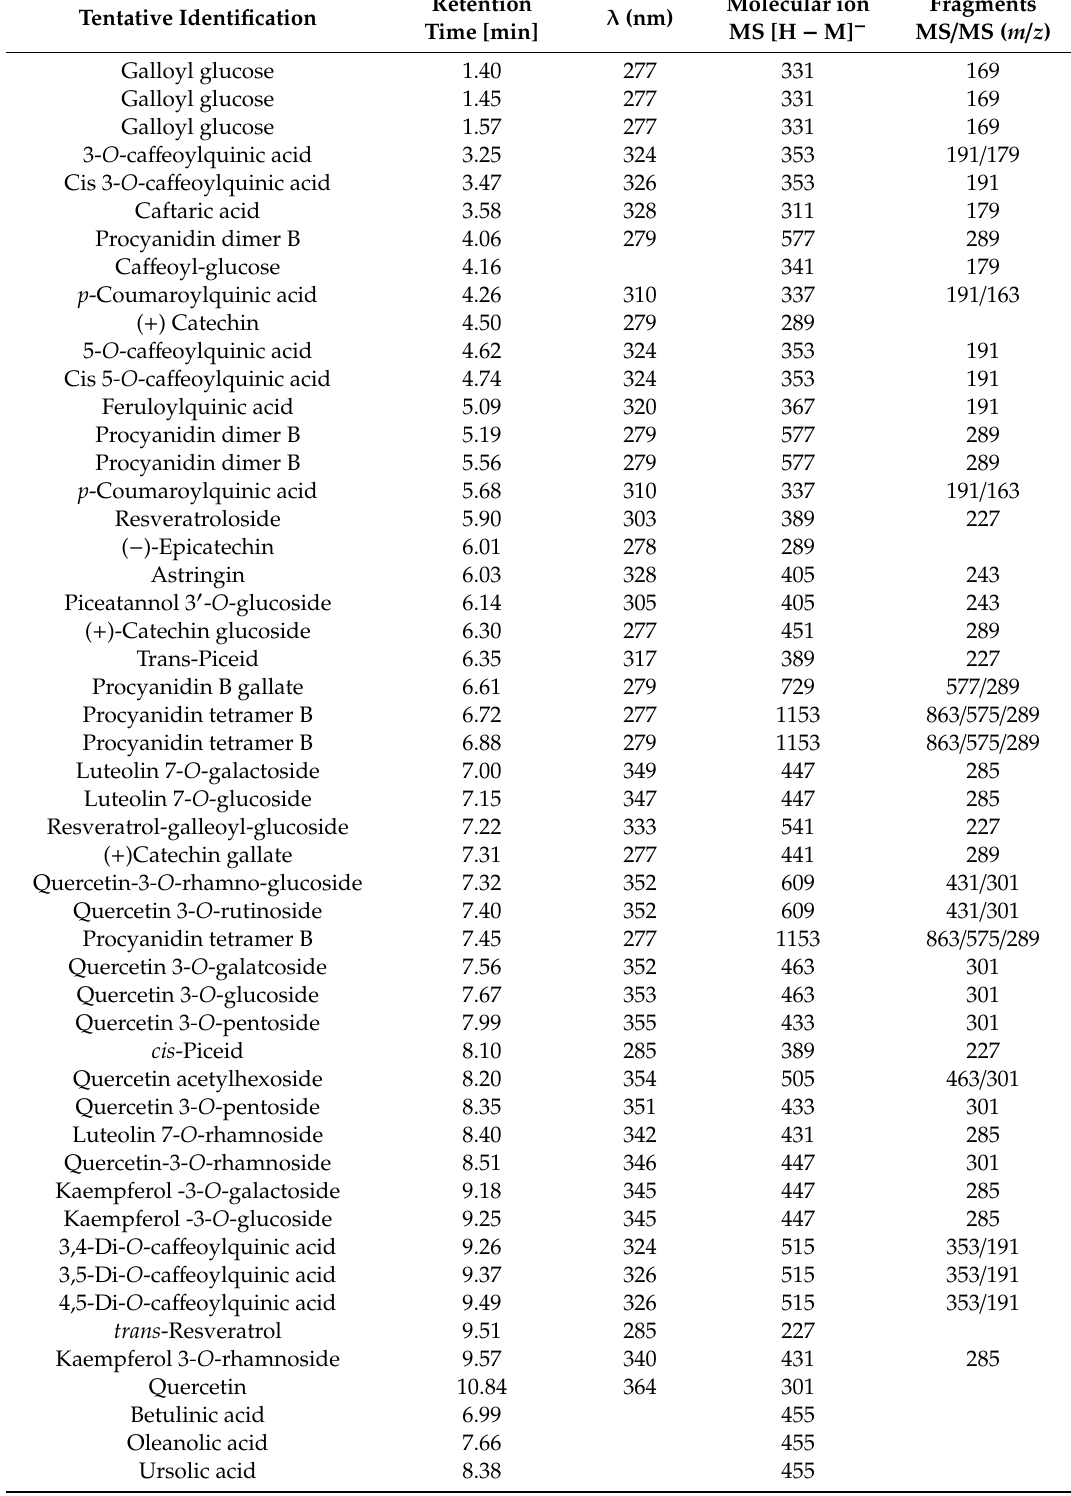
Table 1. Content of polyphenolic derivatives in wild Fallopia japonica (Houtt) and Fallopia sachalinensis (F. Schmidt) leaves, stalks, and